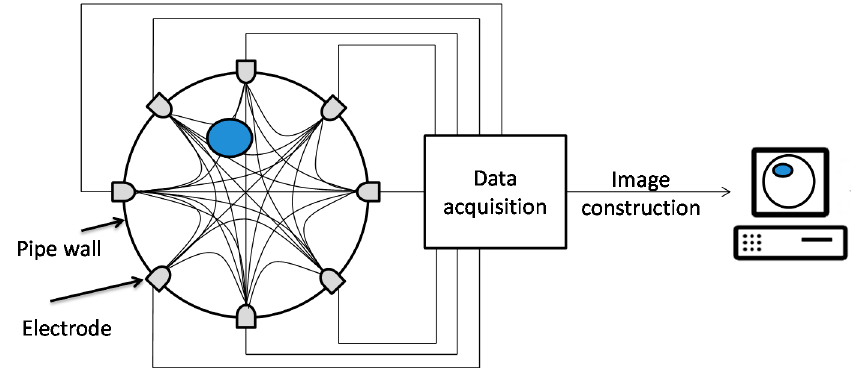
Figure 5. Typical intrusive electrical impedance tomography system with eight electrode sensors with sensing boundary.